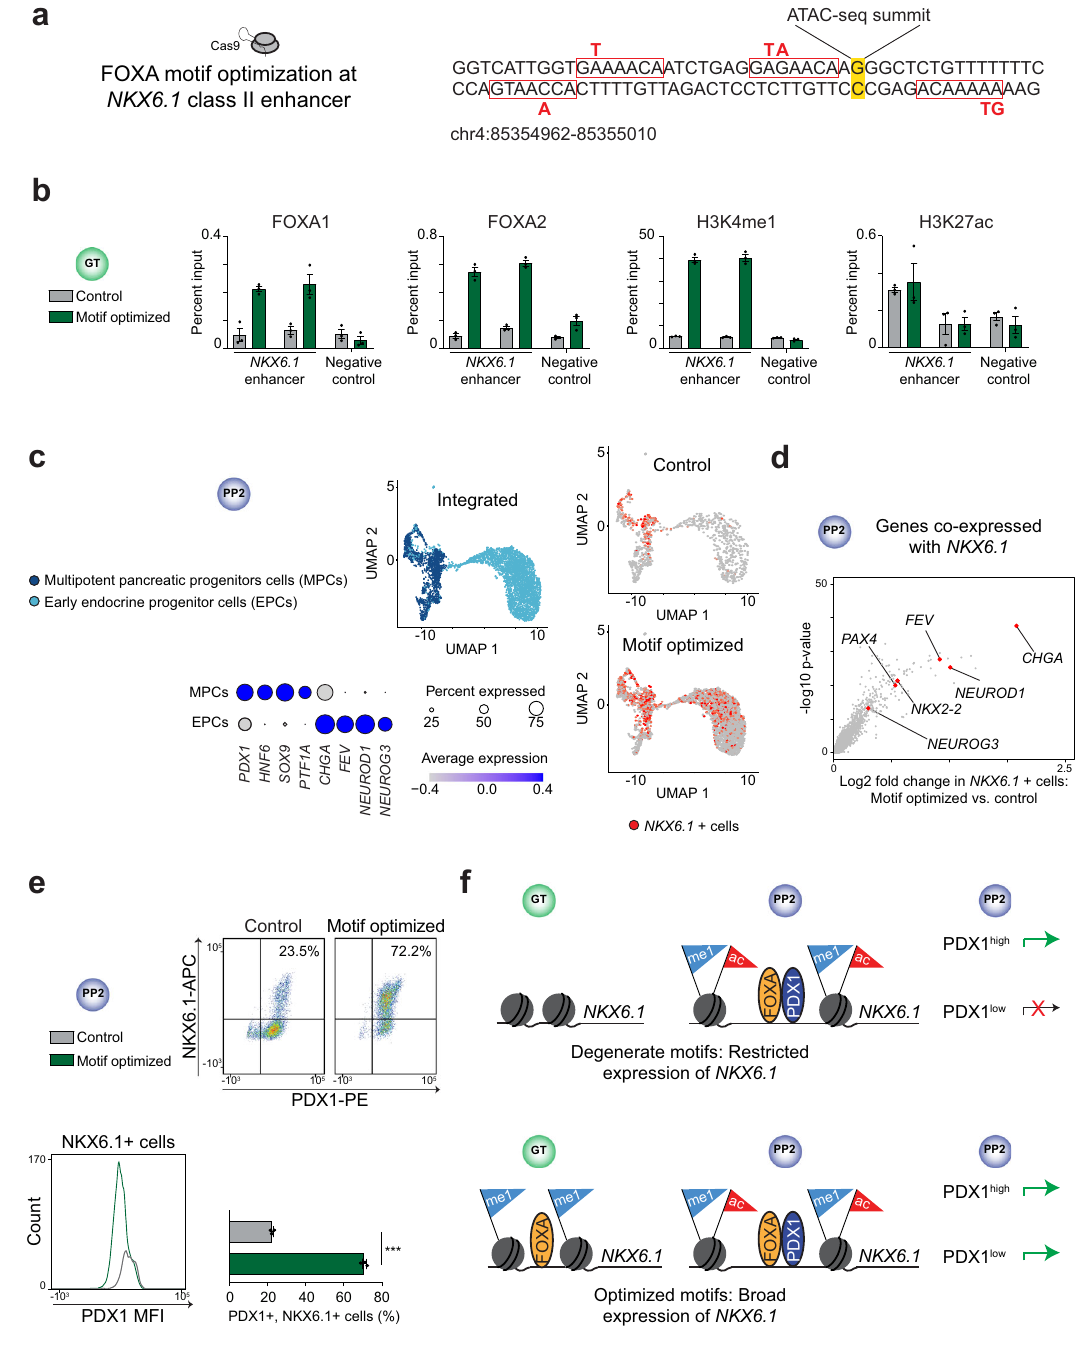
Fig. 6 Optimization of FOXA-binding motifs at an NKX6.1 enhancer rede fi nes patterns of FOXA association and gene expression. a Schematic illustrating base editing strategy at NKX6.1 enhancer via CRISPR-Cas9. Degenerate FOXA-binding motifs and base edits are indicated in red. b ChIP-qPCR comparing FOXA1, FOXA2, H3K4me1, and H3K27ac ChIP-seq signal at the NKX6.1 enhancer in control and motif optimized hESC lines at GT stage. Plots show two independent primer pairs for NKX6.1 enhancer and one primer pair for a negative control region; n = 3 technical replicates. c UMAP representation of single-cell RNA-seq data from both control and motif optimized PP2 cells (integrated) and dot plot showing expression of marker genes in each population (bottom). NKX6.1 expression across populations in control and motif optimized cell lines (right). d Volcano plot comparing genes co- expressed with NKX6.1 in motif optimized compared to control PP2 cells. Wilcoxon rank sum test, 2-sided, corrected for multiple comparisons. e Representative fl ow cytometry analysis for PDX1 and NKX6.1, mean fl uorescence intensity (MFI) of PDX1 signal in NKX6.1 + cells, and quanti fi cation of PDX1 + and NKX6.1 + cells in control and motif optimized PP2 cells ( n = 3 independent differentiations; P < 1.0 × 10 − 4 ; student ’ s t -test, 2-sided). Bar graph shows mean ± S.E.M. f Schematic illustrating temporal patterns of FOXA recruitment and NKX6.1 expression at the PP2 stage in cells with degenerate and optimized FOXA motifs at the NKX6.1